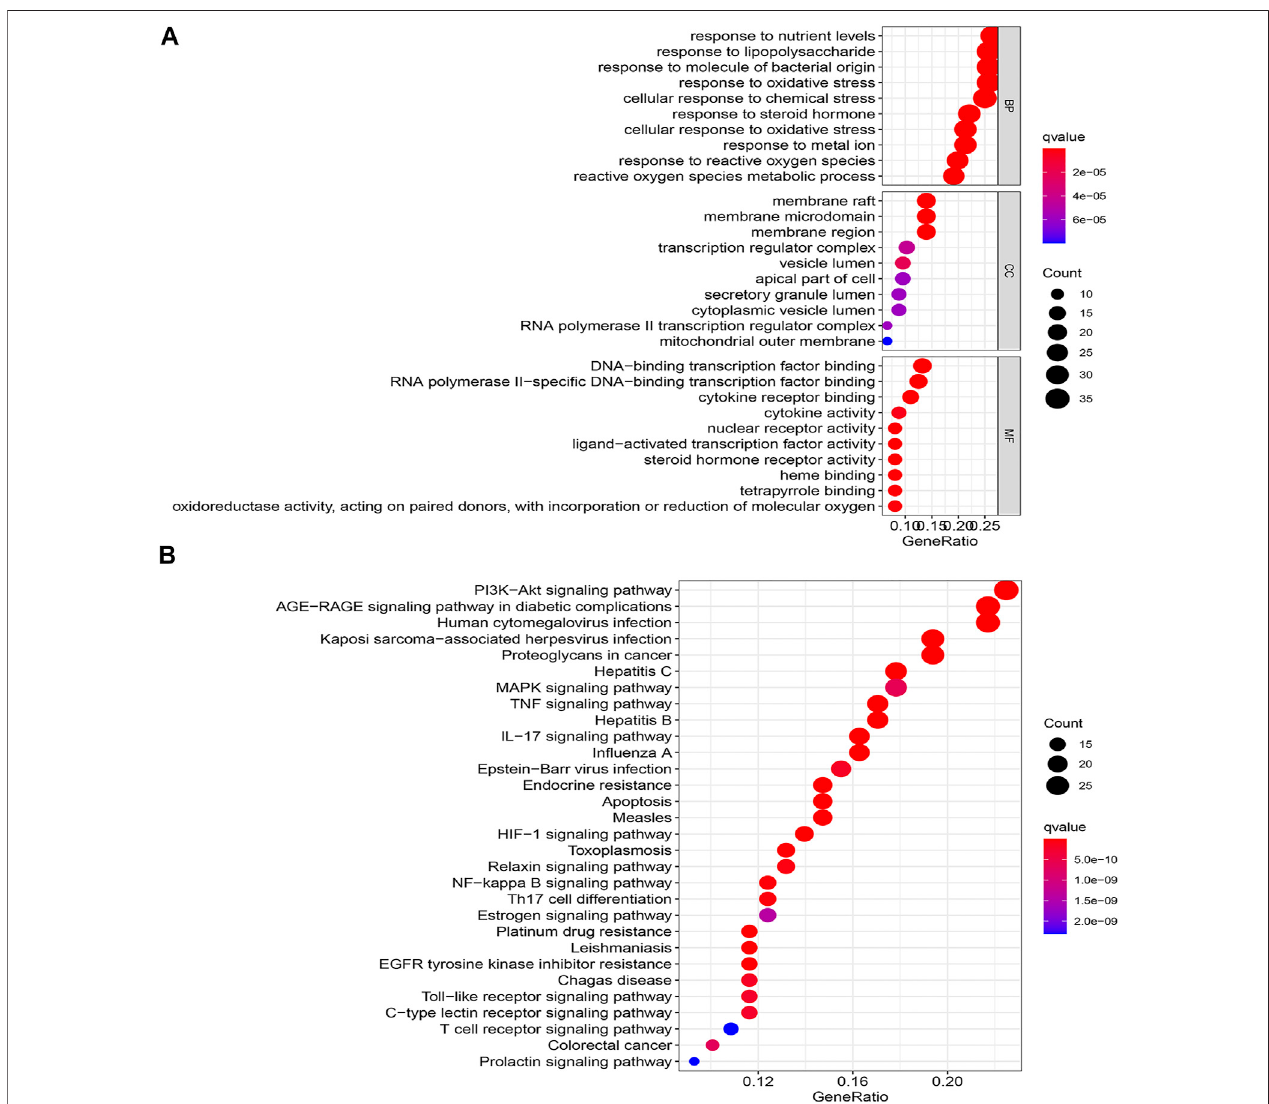
FIGURE 4 | GO and KEGG enrichment analyze (A) : GO enrichment analyze, (B) : KEGG enrichment analyze.